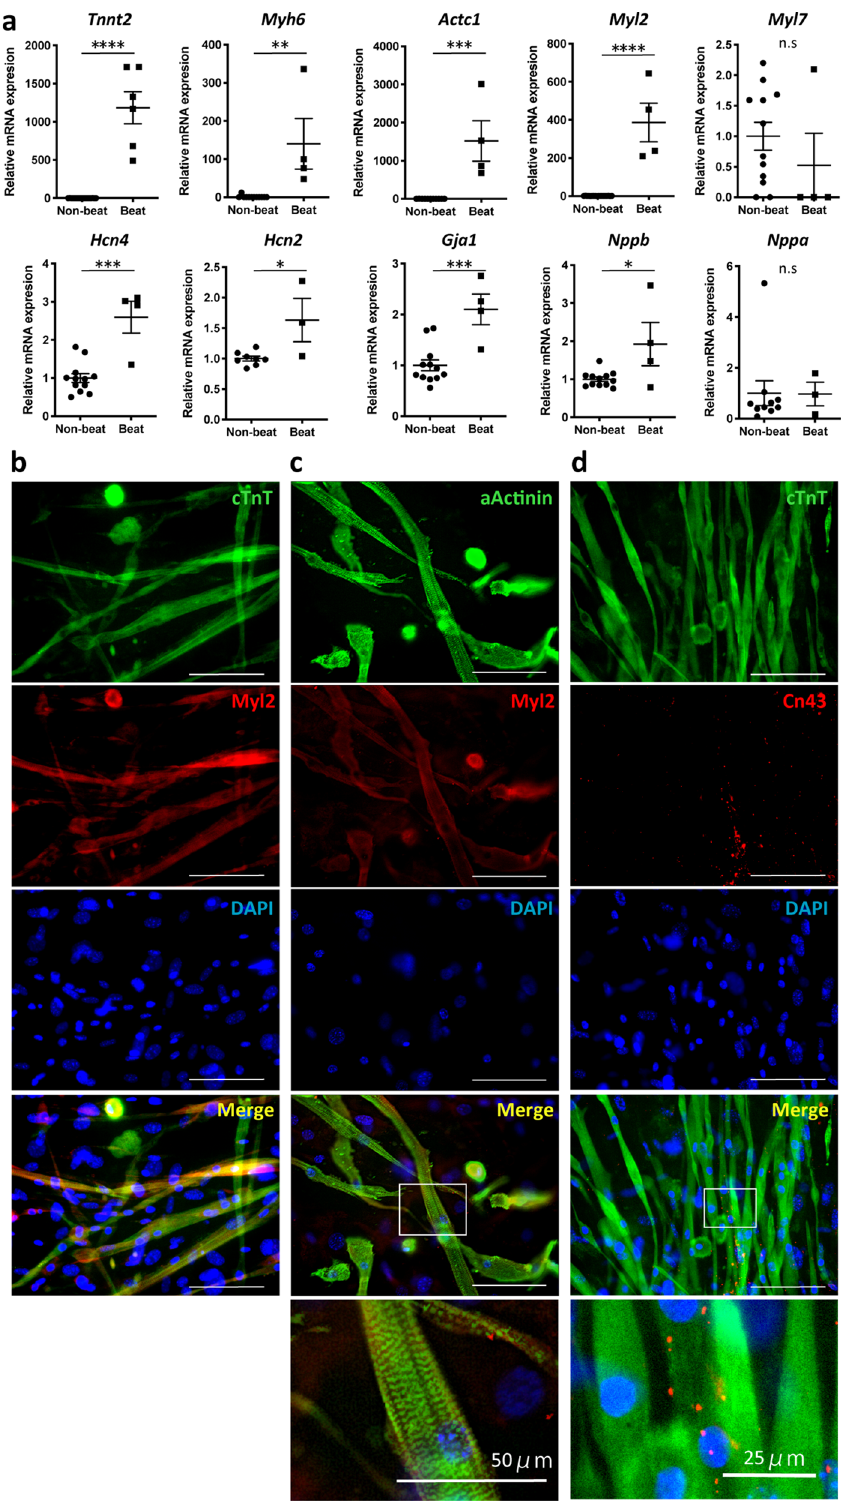
Figure 4. SVF beating cells have a cardiomyocyte phenotype. ( a ) mRNA levels of cardiomyocyte-specific sarcomere proteins, ion channels, and secreted proteins in the beating and non-beating groups. ( b ) Representative immunofluorescence images of beating cells stained for cardiac troponin T (cTnT), Myl2, alpha-actinin (aActinin), and connexin-43 (Cn43) on day 28 after cultivating SVF. White square, area of interest (shown below at higher magnification). Scale bar, 100 µm. * p < 0.05; ** p < 0.01; *** p < 0.001; **** p < 0.0001 by t -test. DAPI, 4 ′ ,6-diamidino-2-phenylindole; SVF, stromal vascular